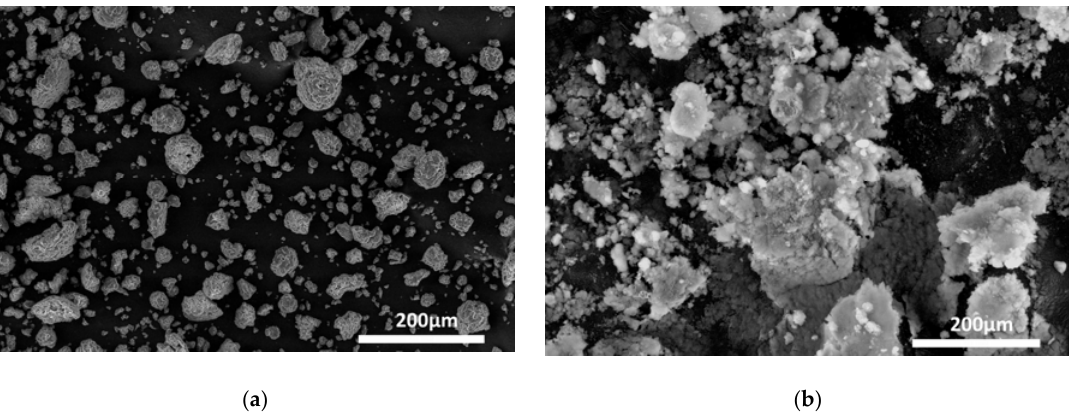
Figure 3. SEM images of kraft lignin ( a ) and the kraft lignin/silica system ( b ).